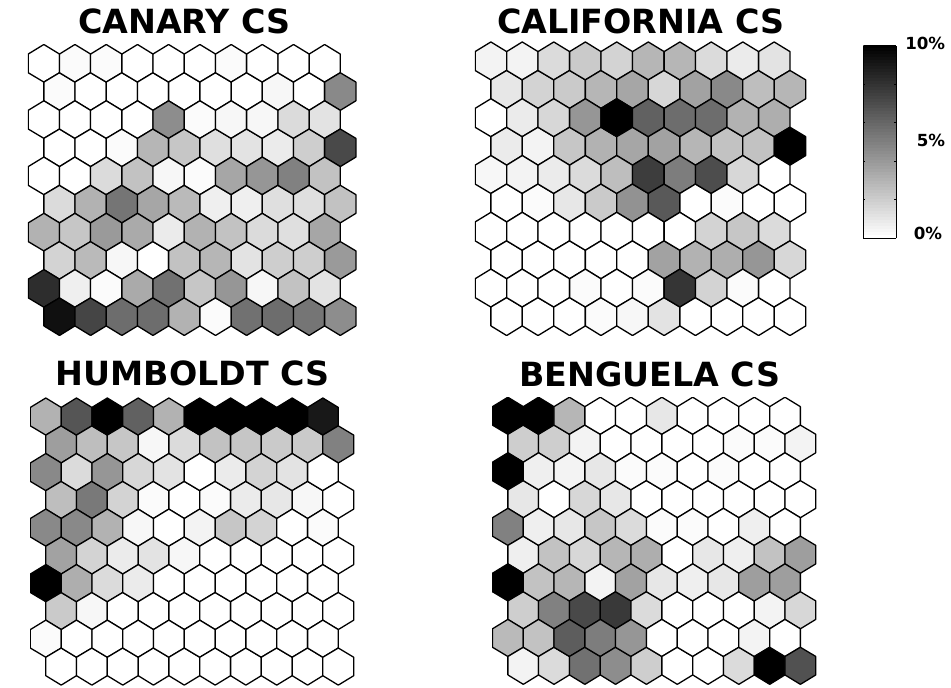
Fig. 11. Distribution of the Canary, California, Humboldt and Benguela Current systems on the SOM. The grey shading corresponds to the fraction of observations associated with each